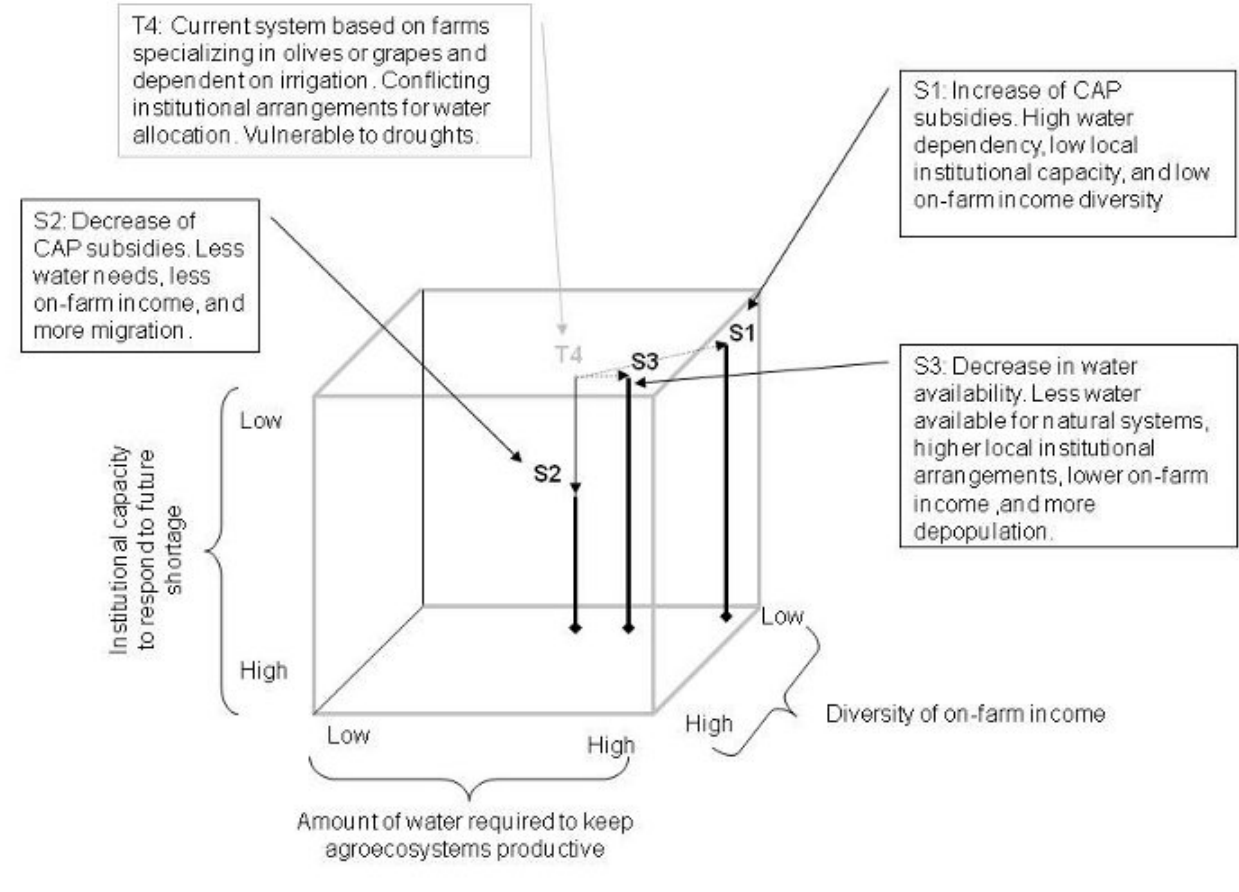
Fig. 8. The vulnerability space showing the historical state (T4, as in Fig. 5) and the future virtual states (S1, S2 and S3) based on the policy